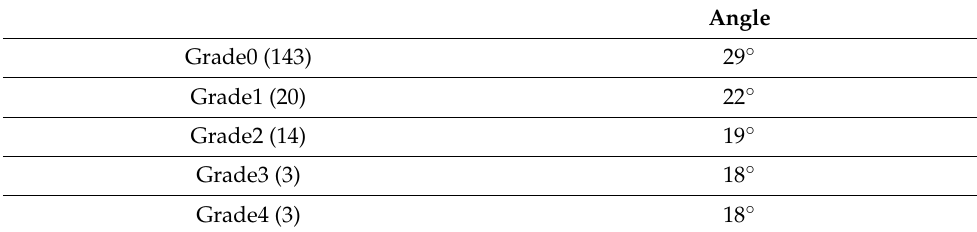
Table 2. Screw insertion angle.